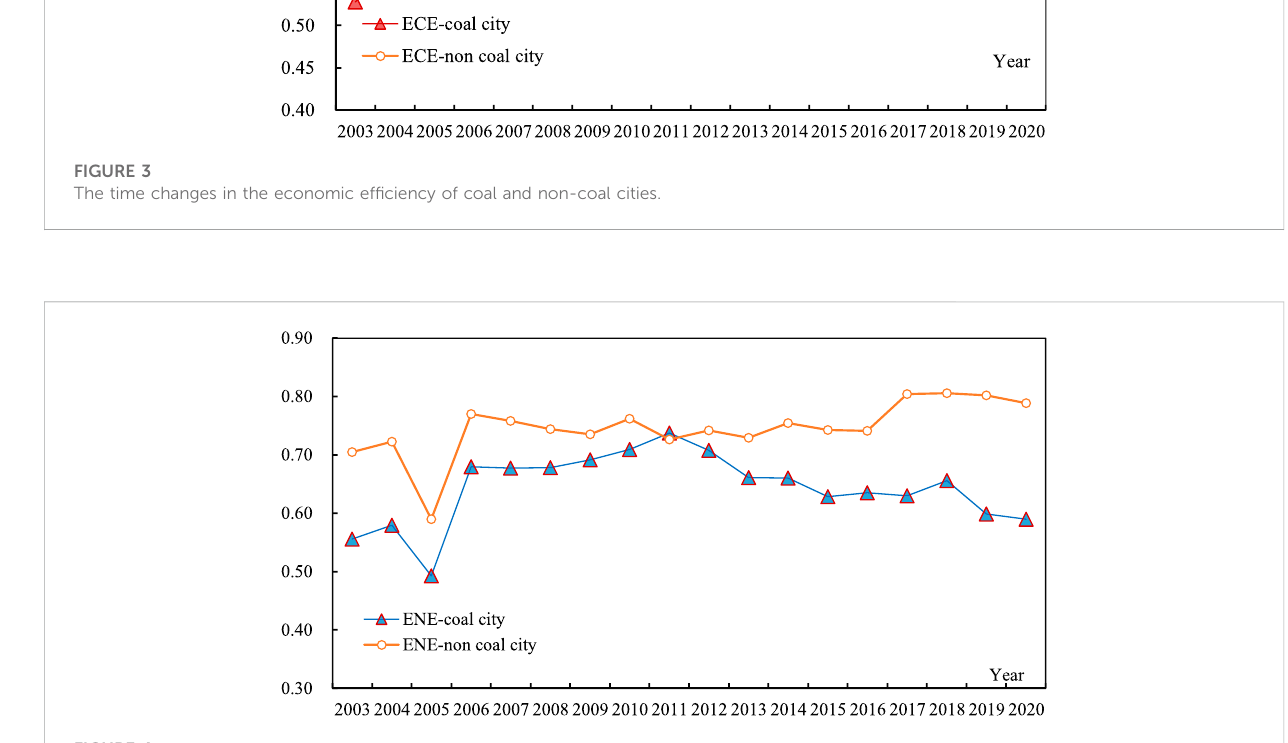
The time changes in the environmental ef fi ciency of coal and non-coal